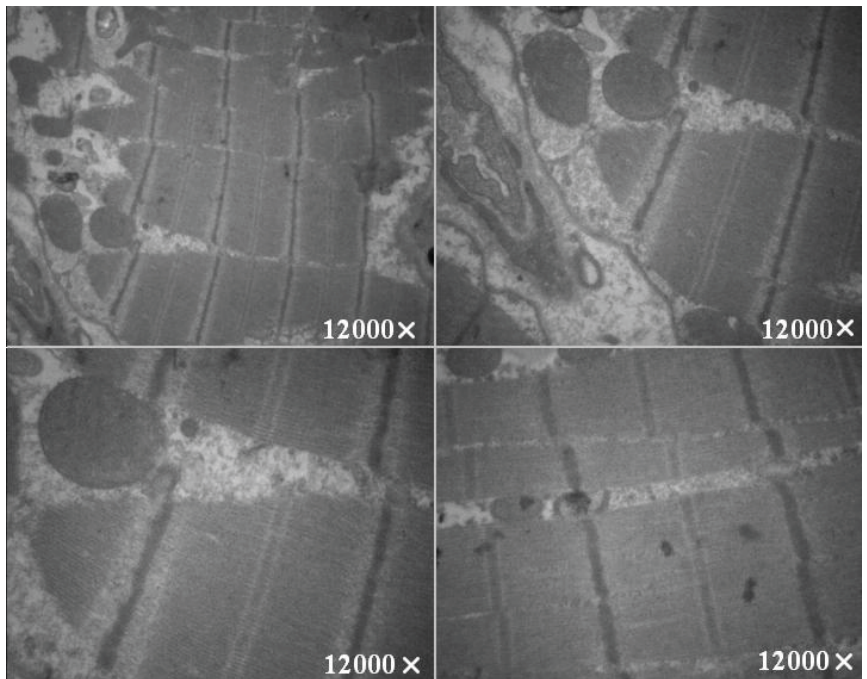
Figure 8. Electron micrographs of heart muscles of defibrillated dogs. Note that the sarcomeres and z-lines are